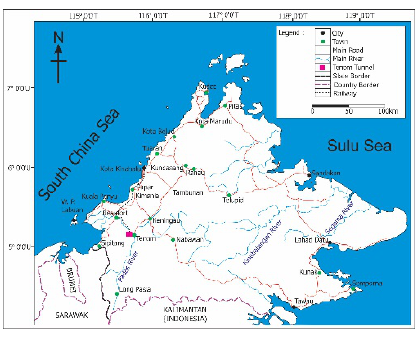
Figure 1: Location of Tenom Tunnel.